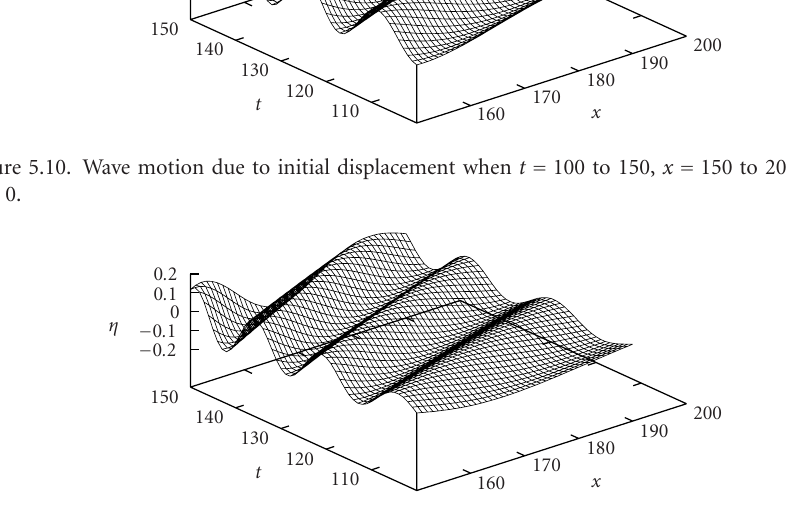
Figure 5.11. Wave motion due to impulse when t = 100 to 150, x = 150 to 200; (cid:1) = 0, D =